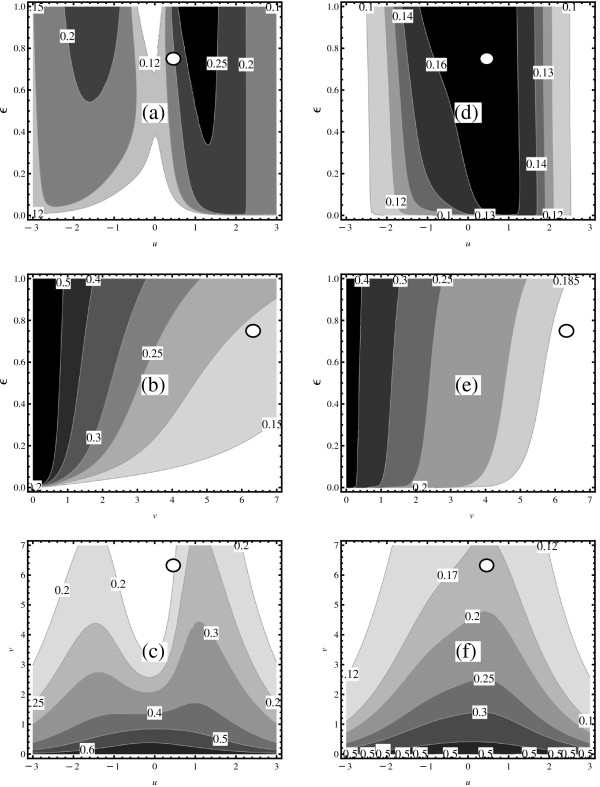
Phase diagrams for the dose reduction coefficient. The panels (a-c) and (e-f) depict contour plots of the dose reduction coefficients ΘPH(λ→) and ΘPS(λ→) respectively. For both quantities three hyperplanes are considered: (a) and (d) for (v=vR,u,ϵ), (b) and (e) for (v,u=uR,ϵ), (c) and (f) for (v,u,ϵ=ϵR). The position of the resistor model operating point is marked by the white circle. In all plots for lighter (darker) regions the dose reduction coefficient has relatively small (large) values. In lighter (darker) regions the noise-based treatment is (not) advantageous over noise free treatment. For operating points that are located in light regions the noise-based treatment can bring relatively large dosage reductions while in the dark regions it might not be that advantageous if compared to a noise-free treatment.